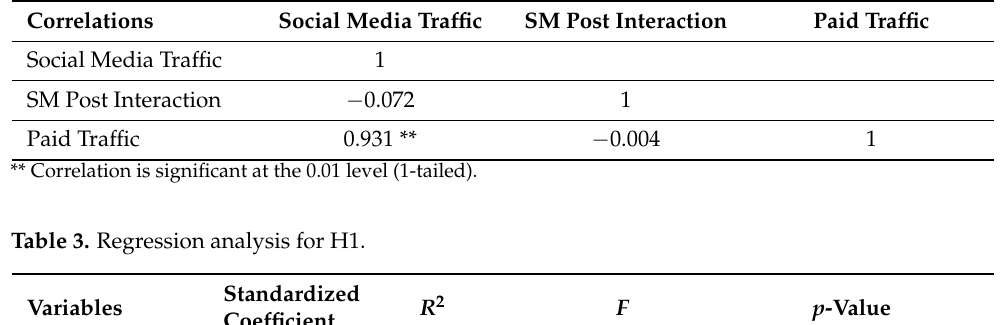
Table 2. Pearson’s correlations of the H1.